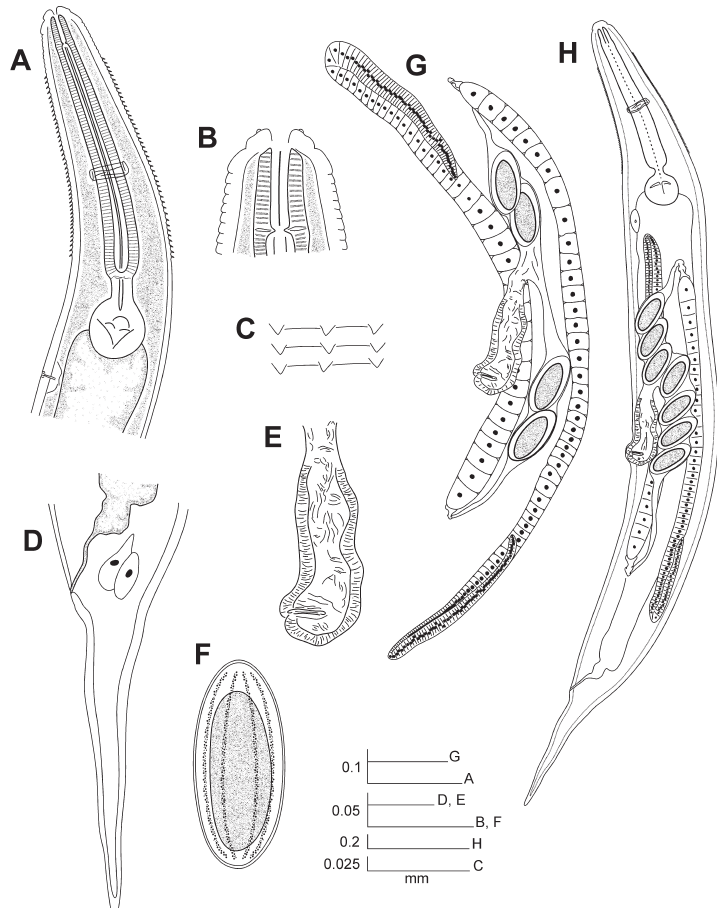
Figure 1. Hystrignathus dearmasi sp. n. female. A Esophageal region, lateral view B Cephalic region and stoma C Cervical spines D Tail, lateral view E Vulva, ventro-lateral view F Egg G Genital tracts H Entire